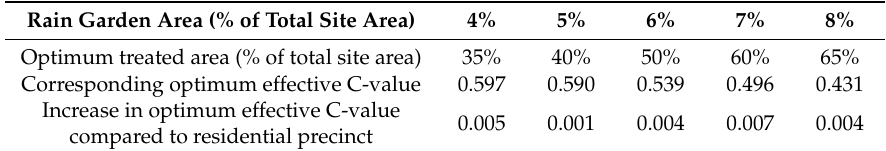
Table A10. Mixed precinct results of optimum treated areas and C-values for various rain garden sizes.